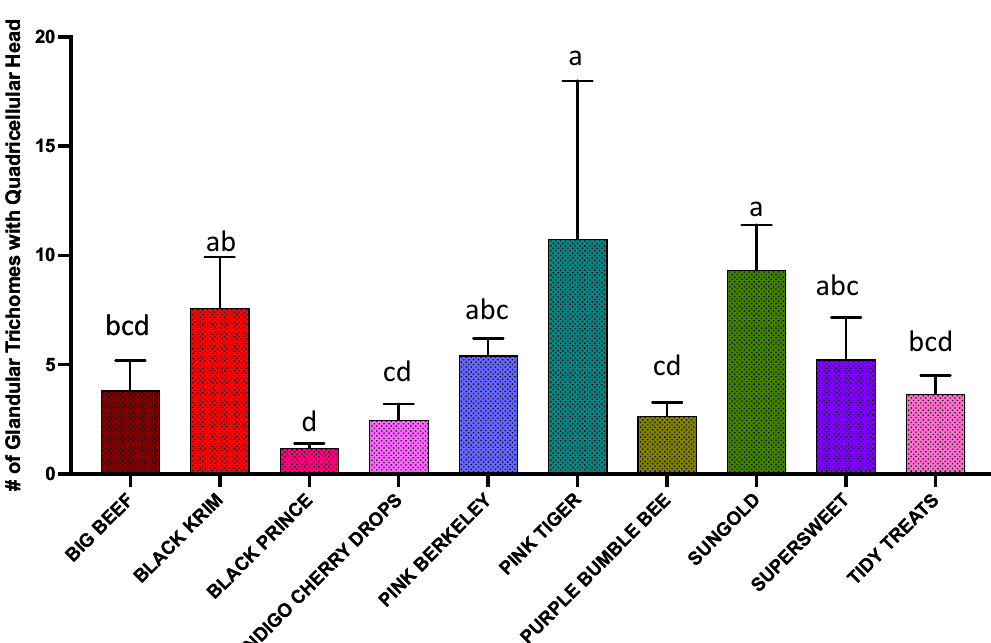
Fig. 6 The comparison of total number of glandular trichome with large quadricellular head (which is most common among varieties) present in ten varieties of tomato